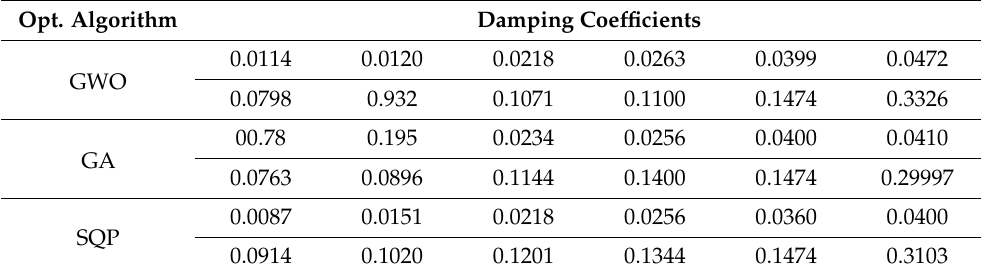
Table 9. Optimization results of damping coefficients (12-DOF model—combined loading).